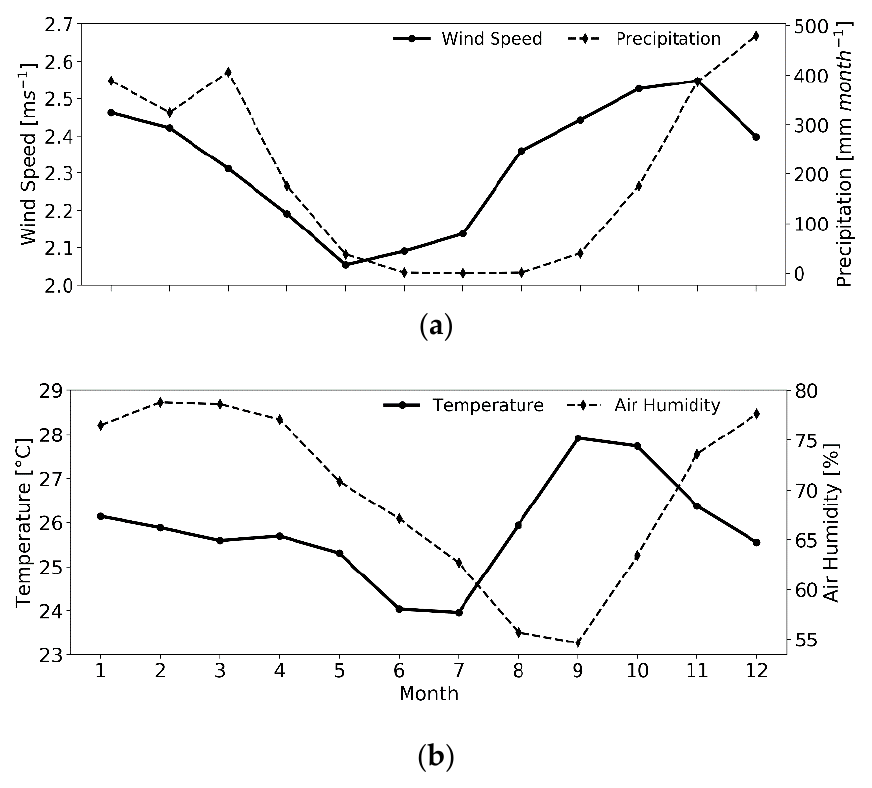
Figure 3. Climate seasonal patterns observed at the Serra da Mesa Reservoir over the period of 2005 − 2010: monthly mean of ( a ) precipitation (mm month − 1 ) and wind speed (ms − 1 ); ( b ) air temperature (°C) and relative humidity (%).